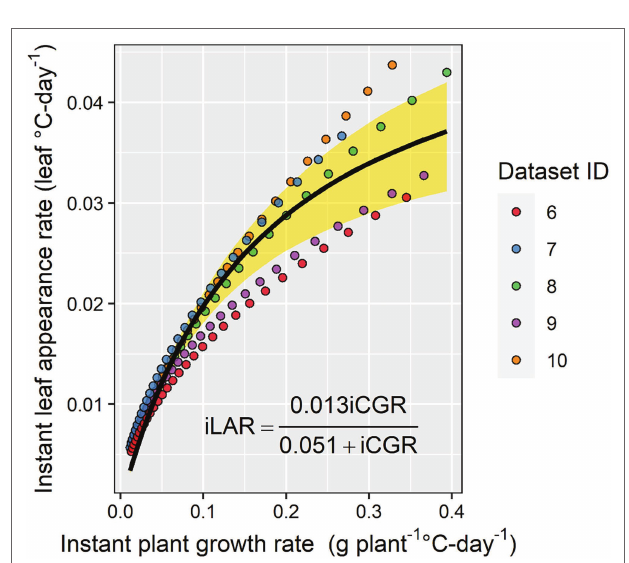
FIGURE 6 | The relationship between instant leaf appearance rate and instant crop growth rate. The yellow shaded area represents the 95%